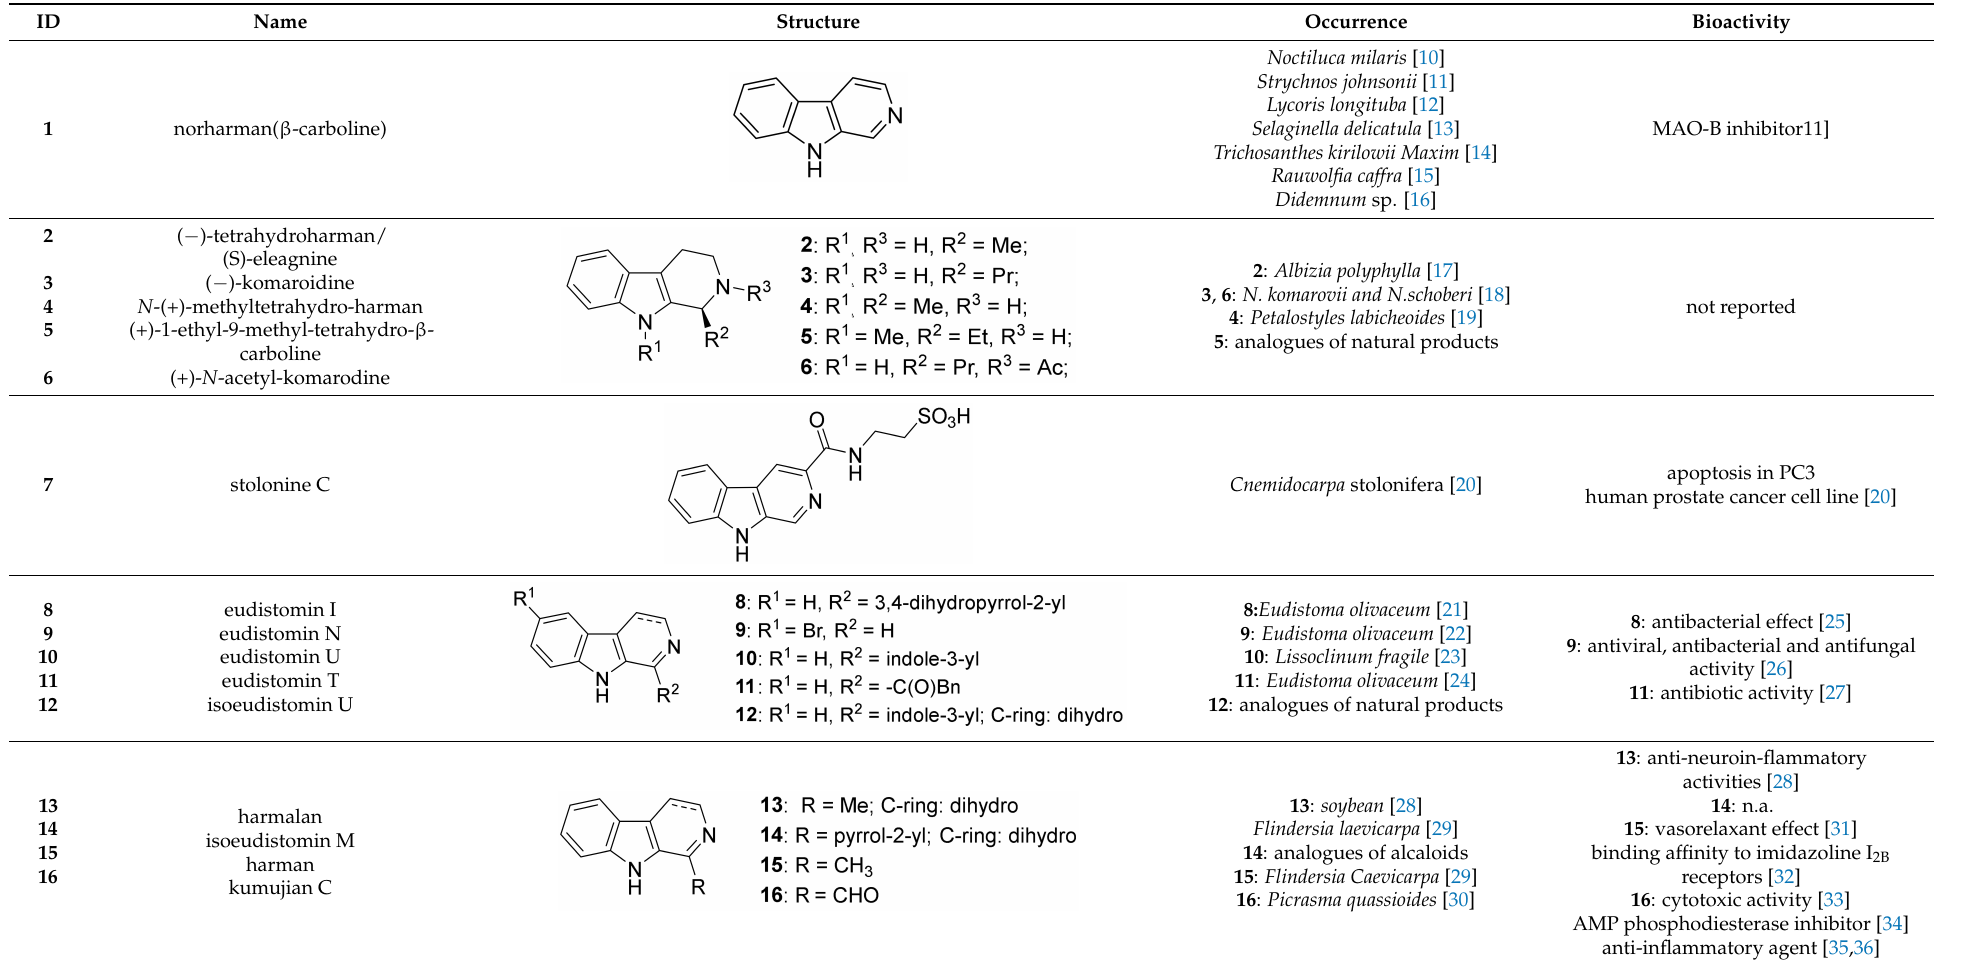
Table 1. Synthesized β -carbolines with their natural occurrence and